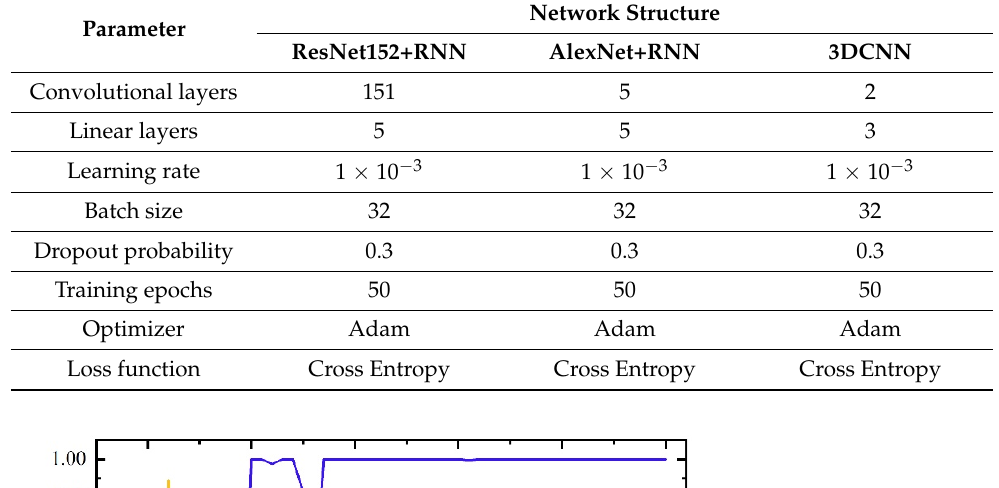
Table 1. Parameter settings of the three networks.